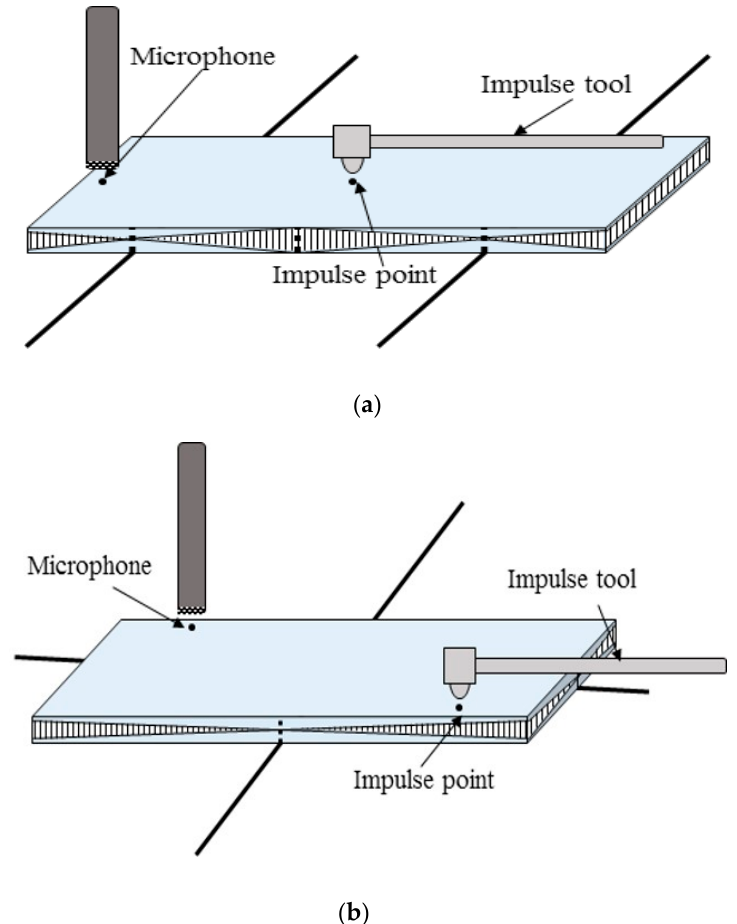
Figure 3. Flexural test in IET ( a ) and torsional test in IET ( b ).